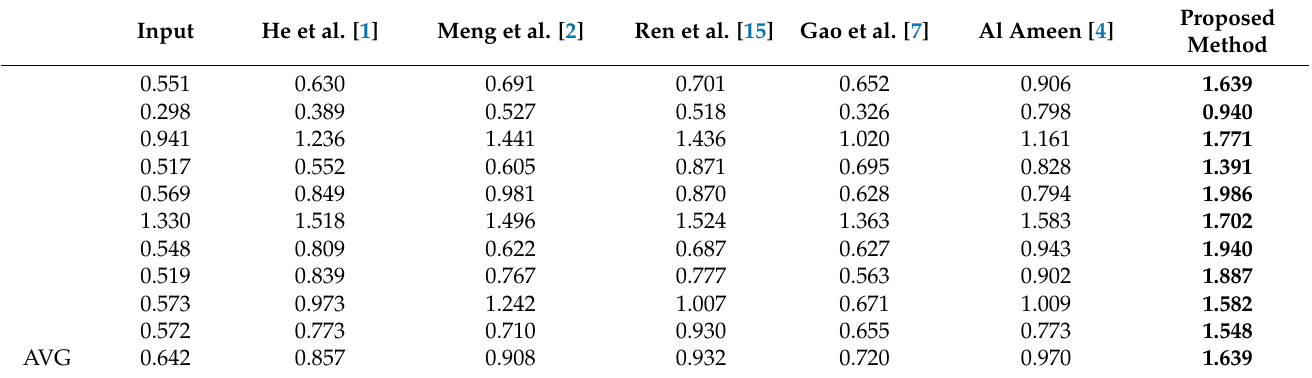
Table 2. The comparison of the UIQM [34] scores from Figure 6 (If the score is high, the image is well enhanced. The highest are indicated in bold ).